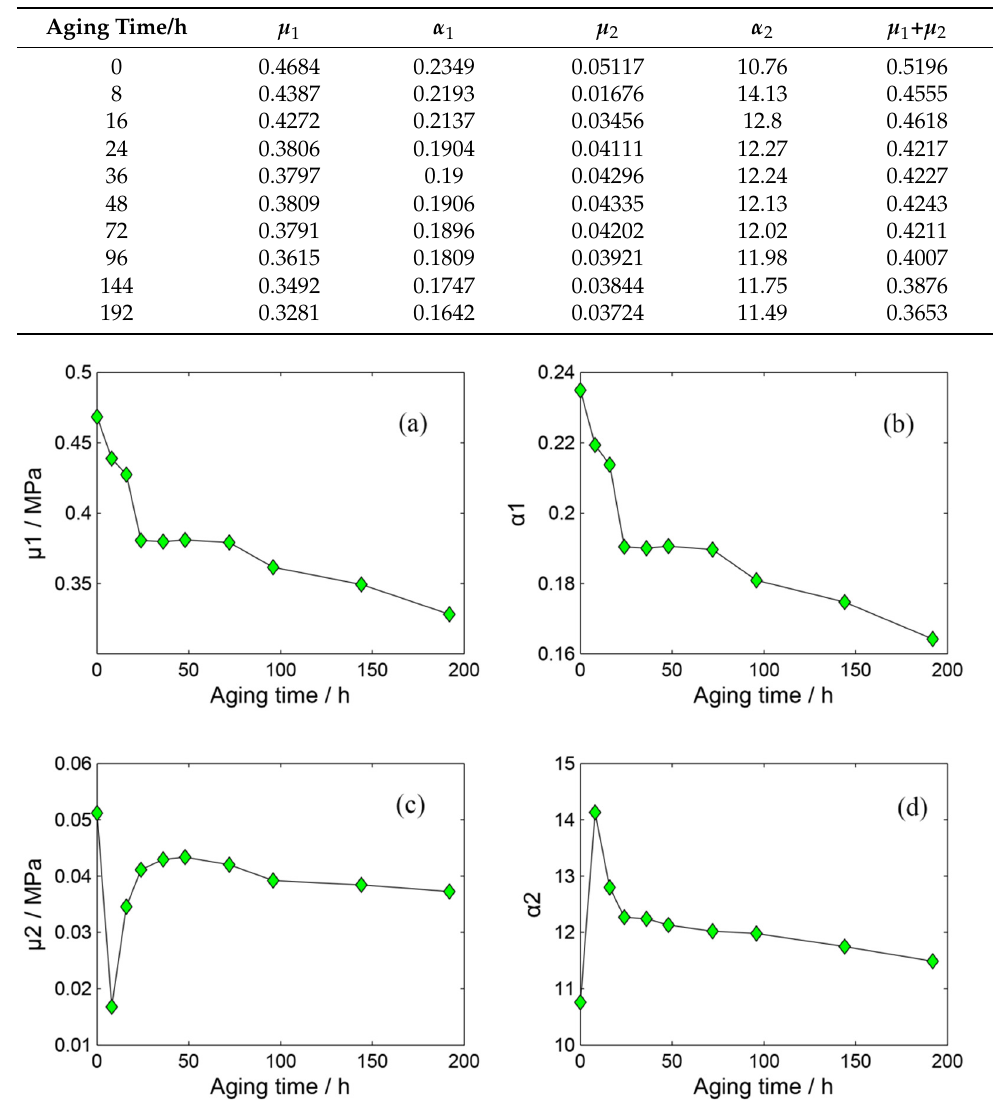
Table 1. Constitutive model parameters at various temperatures.